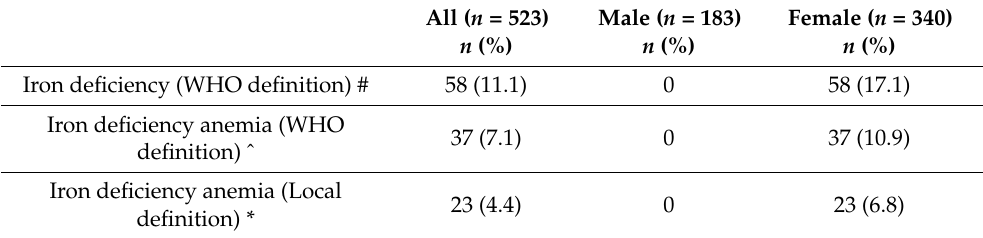
Table 2. Rates of iron deficiency and iron deficiency